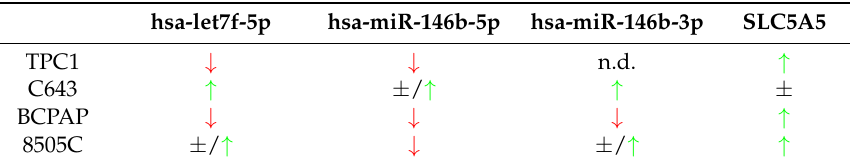
Table 2. Expression of miRNAs and SLC5A5 transcript in TPC1, C643, BCPAP and 8505C cells after treatment with 10 µ M Selumetinib. For final representation, PCR data (fold change compared to untreated sample) were classified as follows: ↓ < 0.5; ↑ > 10; ± no variations/stable; n.d. not detectable.